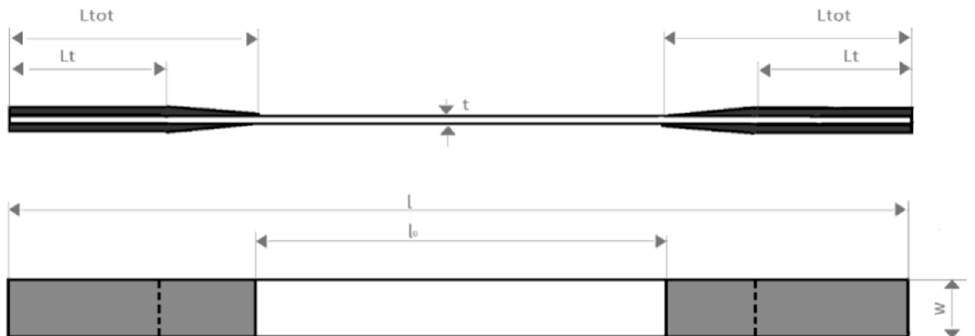
Figure 1. Geometry of the tested specimens.